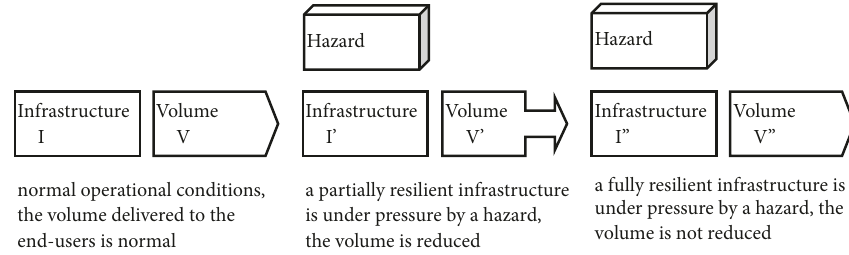
Figure 2: Three simplified hypothetical scenarios on the delivered volume in normal and disrupted states. Table 3: Mathematicaland conceptual representation of volume, time, and volume-over-timeframeworks. ‘R’ means resilience value, ‘ 𝑓 ’ and ‘ 𝜌 ’ mean failure and recovery ratio, ‘v’ and ‘t’ mean volume and time, and ‘D(t)’ and ‘U(t)’ mean disturbed and undisturbed delivery value at a time; encodings for subscripts, ‘d’ for disaster, ‘e’ for the lowest delivery, ‘n’ for normalization, and ‘o’ and ‘c’ mostly technical indicators of the opening and closing the